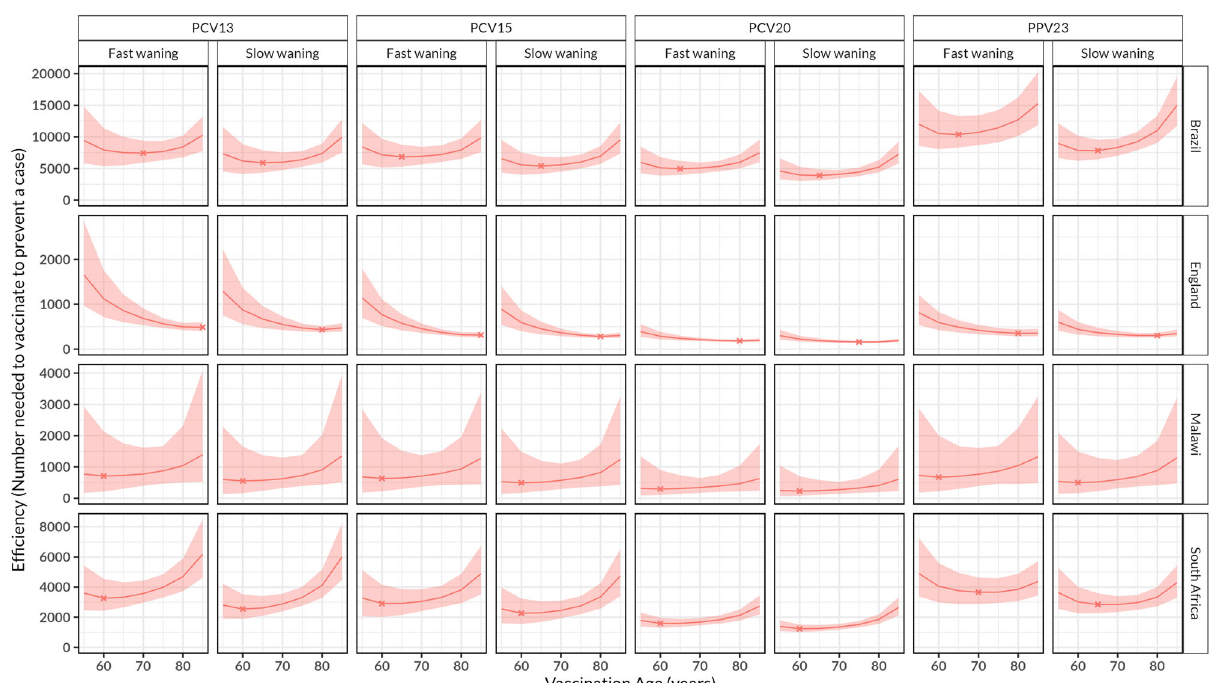
Fig.3|Theef fi ciencyofroutinepneumococcalvaccinationinolderadultsaged ≥ 55yearsold(y). Thenumberofindividualsneededtovaccinatetopreventacase in each age of vaccination, strati fi ed by country and vaccine product, under assumptions of age-independent initial vaccine ef fi cacy/effectiveness (VE) and waning VE in Brazil, England, Malawi and South Africa. The red lines represent